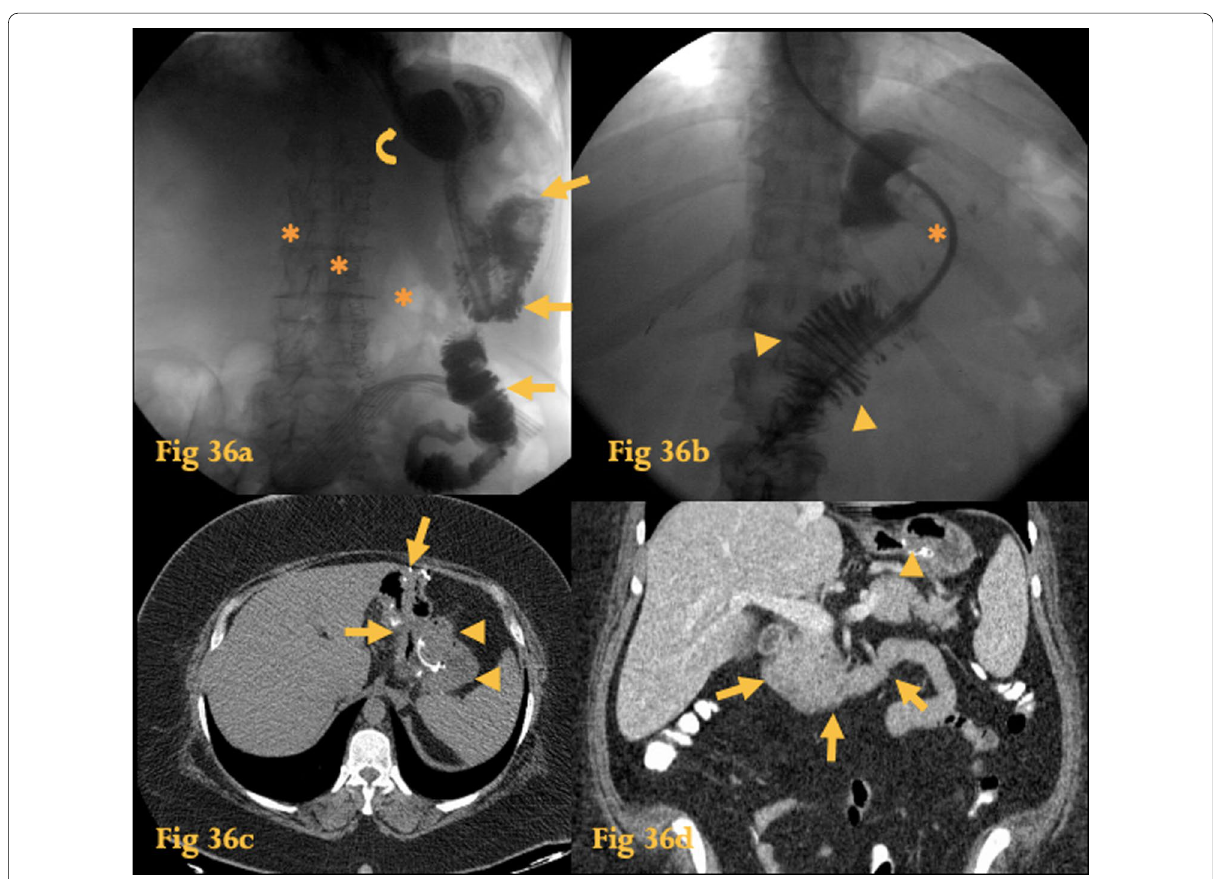
Fig. 36 Roux‑en‑Y anastomosis. UGIS with water soluble contrast of a patient who underwent partial gastrectomy with Roux‑en‑Y anastomosis for an adenocarcinoma of the stomach ( a ): only the gastric stump (curved arrow) and gastro‑jejunal loop are opacified (arrows); the biliopancreatic loop is not (asterisks in its supposed location). Fluoroscopic study with water soluble contrast of an obese woman who underwent gastric bypass with Roux‑en‑Y anastomosis ( b ): note the jejunal mucosal pattern (arrowheads) right after the supposed location of the gastro‑jejunal anastomosis (asterisk). Abdominal CT of the same patient ( c ): the surgical clips are seen at the anastomosis between the gastric stump (arrows) and the jejunal loop (arrowheads). CT coronal reformation ( d ) shows the gastro‑jejunal anastomosis (arrowhead) and the biliopancreatic limb, which includes the duodenum in its normal location